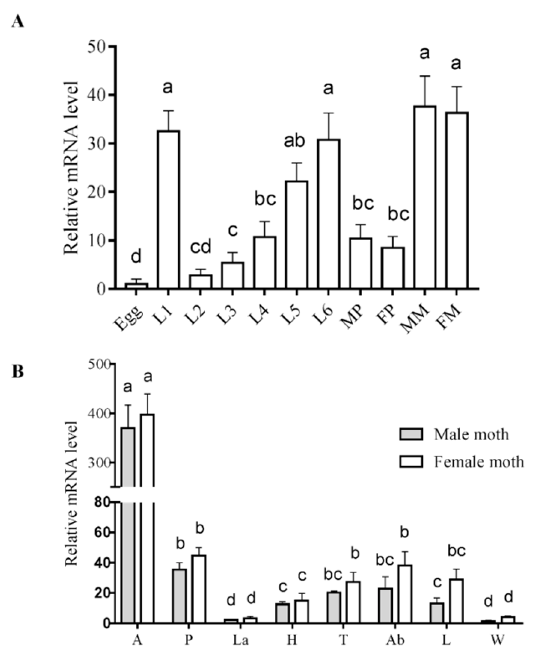
Figure 3. Relative expression levels of SlitGR8 mRNA at di ff erent development stages ( A ) and in di ff erent tissues ( B ). ( A ) L1–L6: 1–6 instar larva; MP: Male pupae; FP: Female pupae; MM: Male moths; FM: Female moths. ( B ) A: Antennae; P: Proboscis; La: Labial palpi; H: Heads; T: Thoraxes; Ab: Abdomens; L: Legs; W: Wings. Di ff erent lowercase letters indicate significant di ff erences ( p < 0.05) based on one-way ANOVA, followed by Tukey’s HSD test for multiple comparisons. Means ± standard